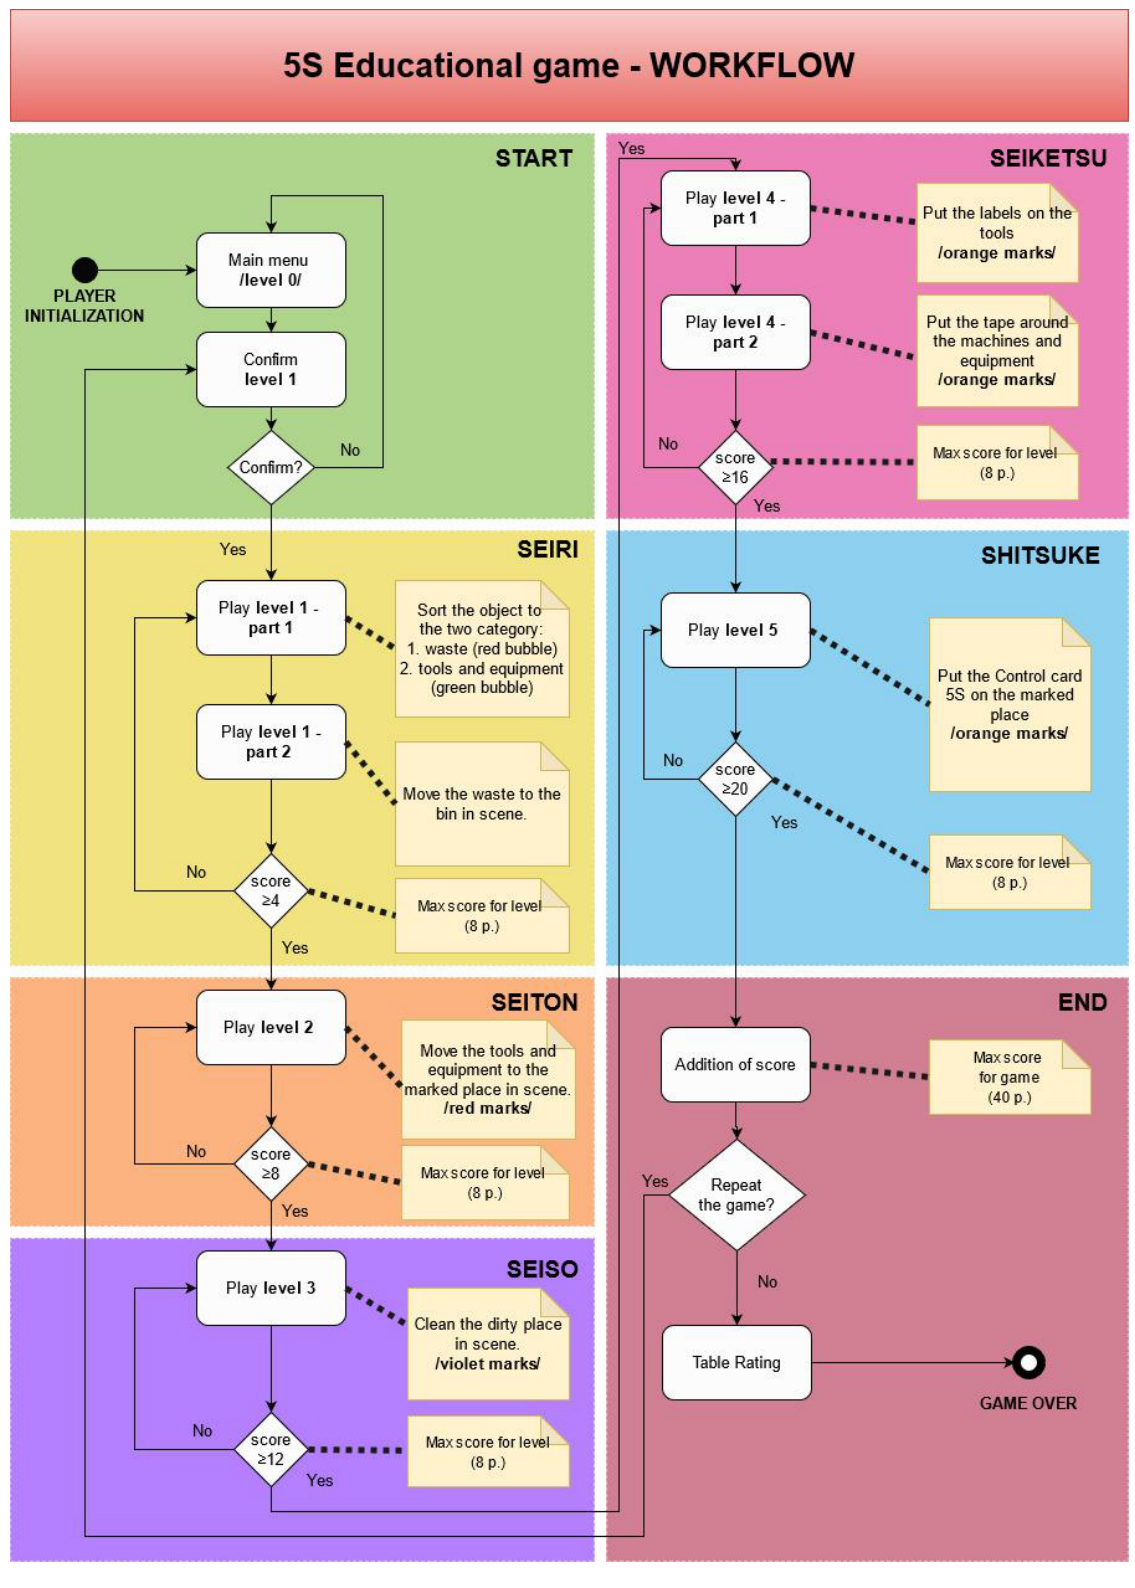
Figure 2. The workflow of the educational game for 5S in virtual reality.